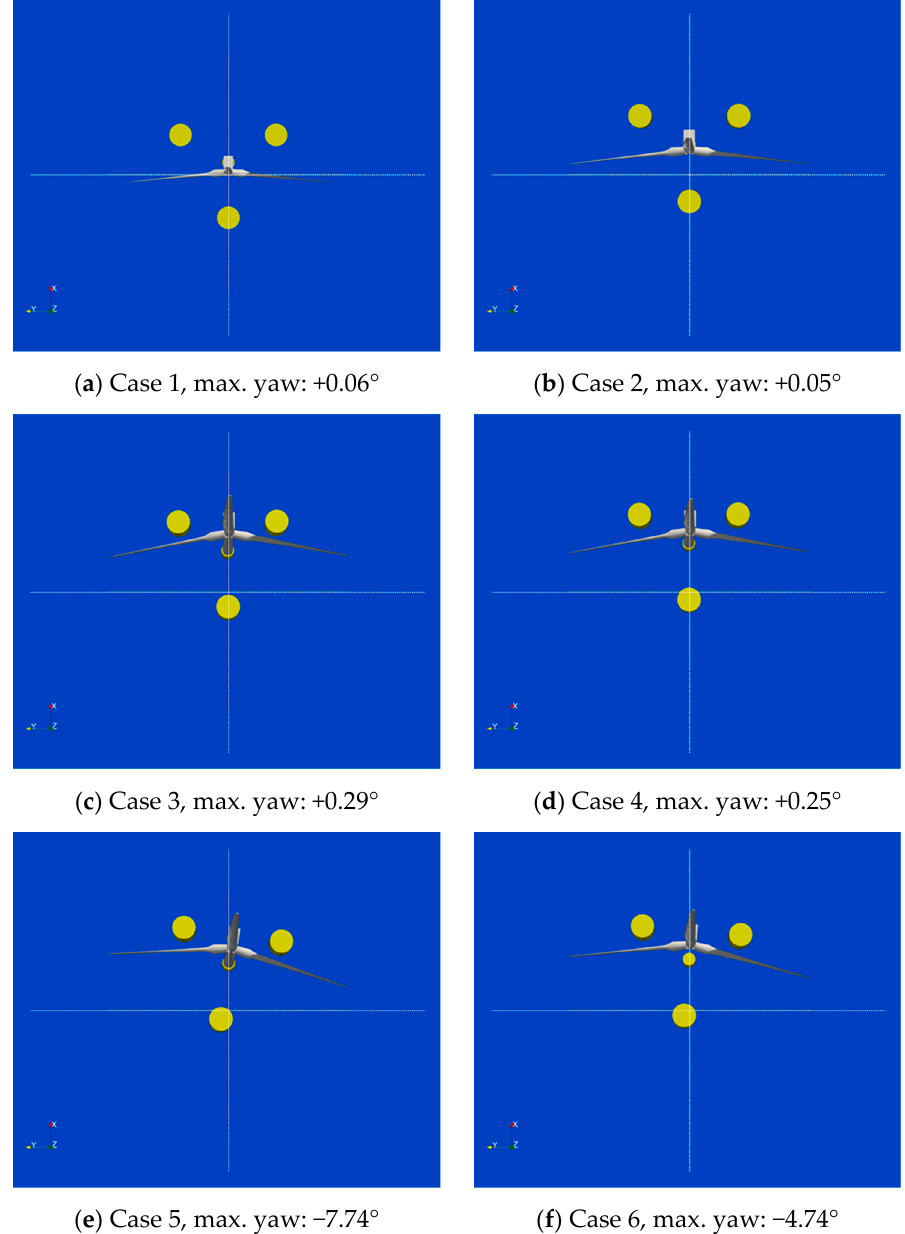
Figure 7. Snapshots when the maximum values of the platform’s yaw motion occurred for the 6 cases.